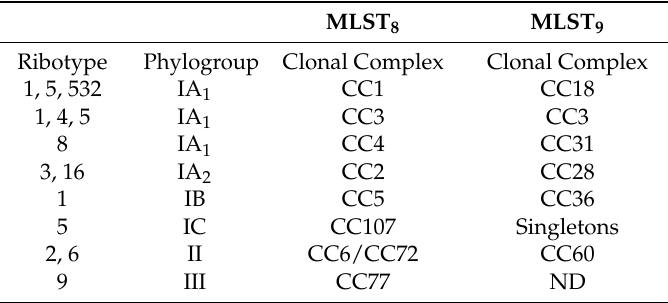
Table 1. Correlation between ribotypes, phylogroups and MLST